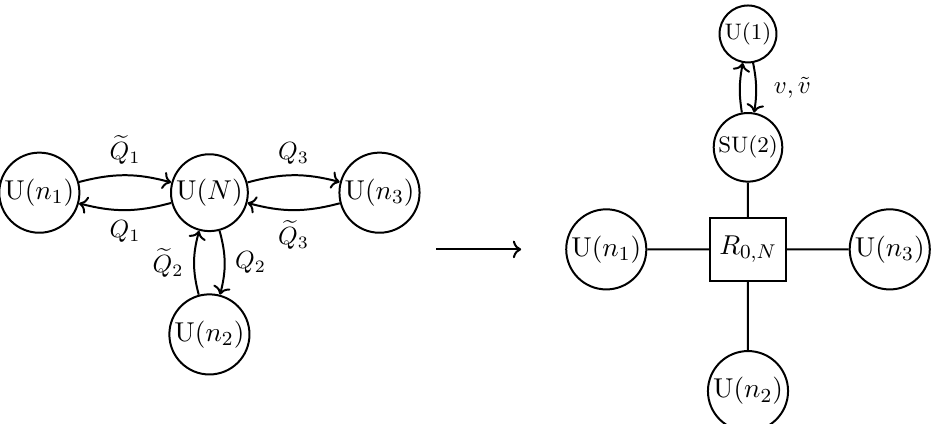
Figure 16 . We replace the U( N ) central node with the non-Lagrangian dual theory in the quiver. where Ψ takes a block diagonal form, with the two adjoint fields Ψ adjacent nodes in the diagonal. Again, this coupling implies, together with X 2 that the Higgs branch is unchanged after replacing the U(3 k )